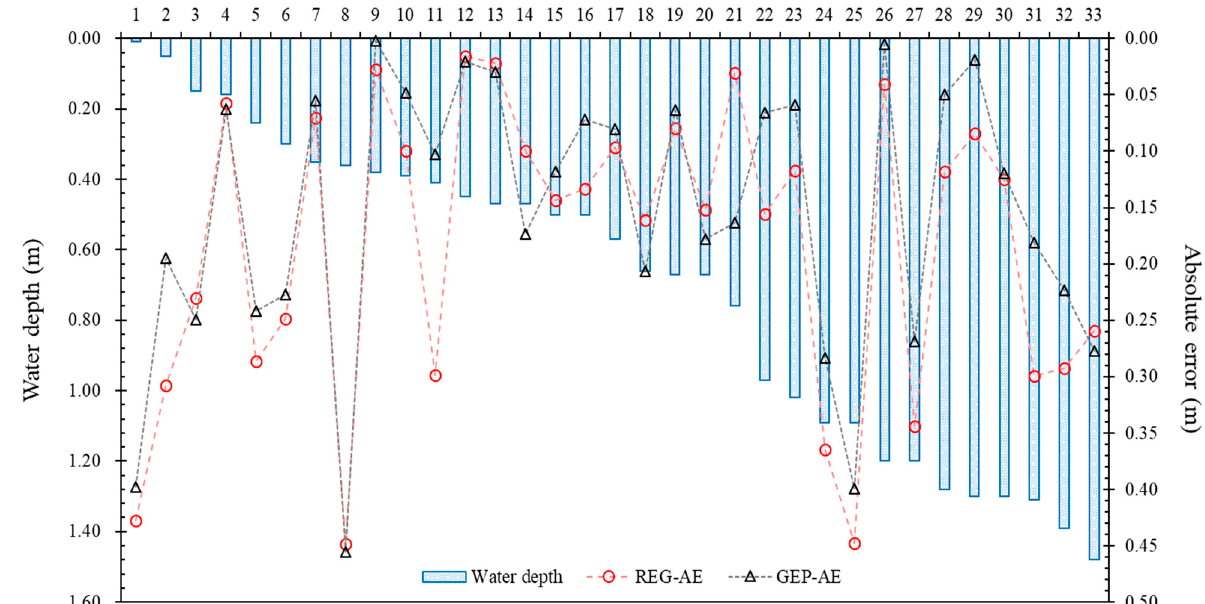
11 of 18 Table 4. Bathymetry retrieval accuracy of GEP and REG models. Model